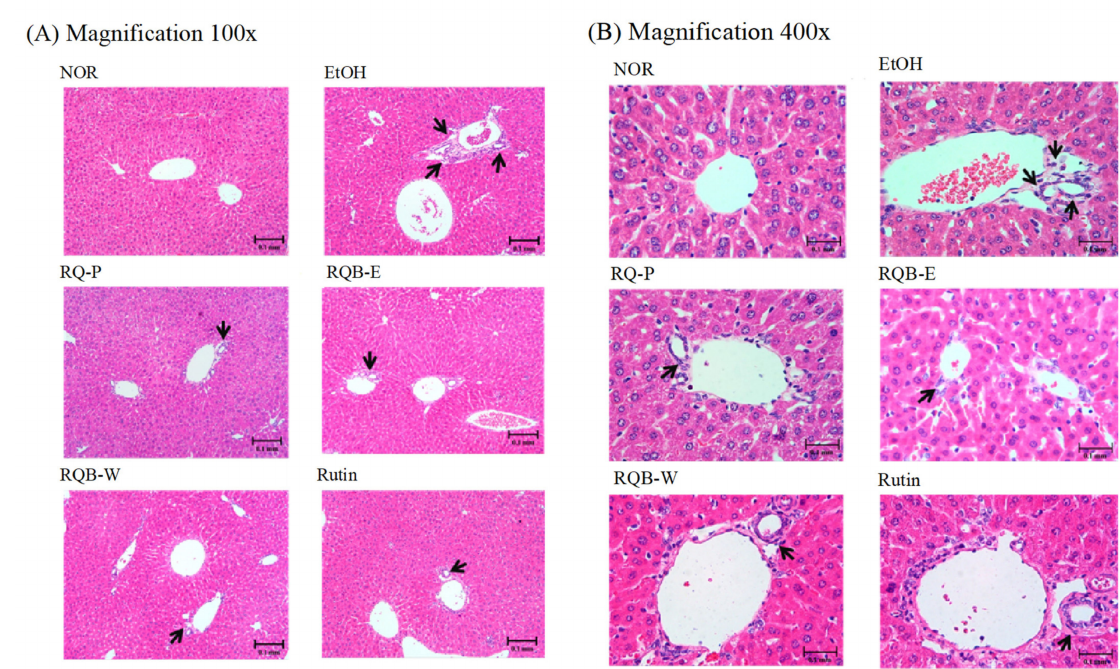
Figure 1. Hepatic pathological changes of the AFLD mice. ( A ) Magnification 100 × , ( B ) magnification 400 × (black arrows indicate the position of liver injury). Two groups of mice were fed with normal liquid diet (NOR group) or ethanol liquid diet (EtOH group) without the administration of test materials, respectively. The other mice fed ethanol liquid diet were administrated with red quinoa powder (5.13 g/kg B.W./day, RQ-P group), red quinoa bran ethanol extracts (1.54 g/kg B.W./day, RQB-E group), red quinoa bran water extracts (1.54 g/kg B.W./day, RQB-W group), and rutin (16.4 mg/kg B.W./day, Rutin group).